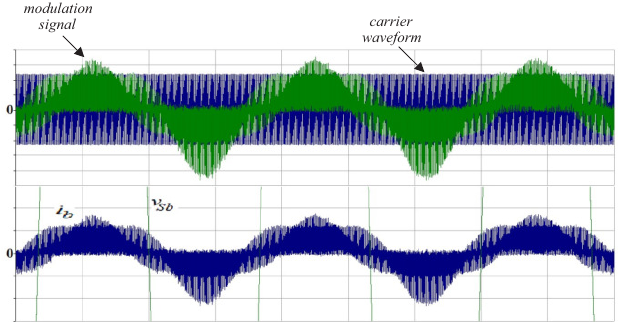
Figure 13. Overmodulation at no-load (5 ms/div). Detailed view. Upper: waveform carrier and modulation signal (0.05 V/div). Down: Grid voltage (2.5 V/div) and phase current (2.5 A/div).